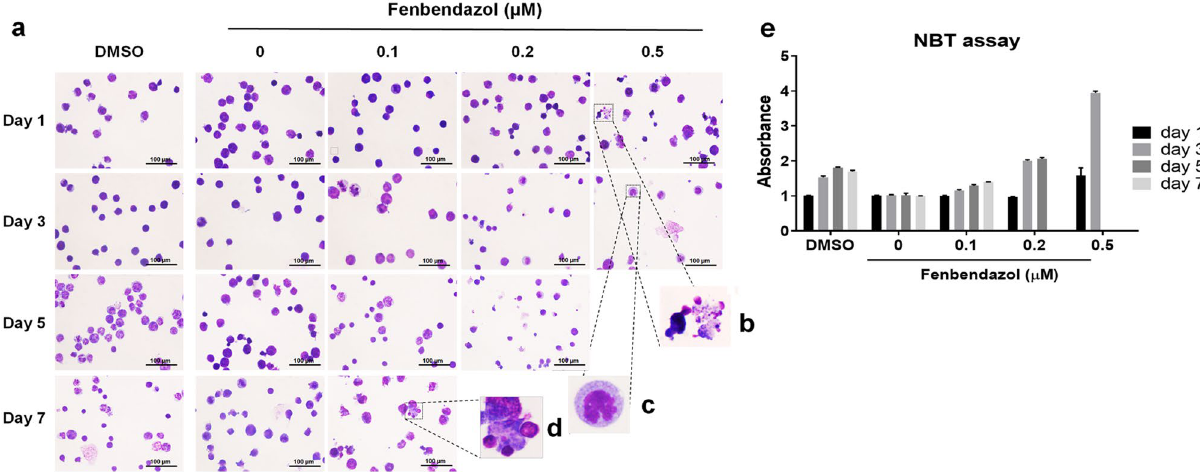
Figure 3. Fenbendazole-induced differentiation of HL60 cells to granulocytes followed by cell death: ( a ) Cell morphology at 1, 3, 5 and 7 days post treatment with 0.1 µM, 0.2 µM and 0.5 µM of fenbendazole via staining with Wright–Giemsa; ( b ) necrotic cells; ( c ) granulocytes; ( d ) apoptotic cells. ( e ) Different concentrations of fenbendazole were employed in the NBT reduction assay at different time points. The assay demonstrates that 0.5 µM of fenbendazole increased NBT reduction upon neutrophil differentiation significantly compared to positive control treatment with DMSO). Hence it can be concluded that the mode-of-action hypothesis fenbendazole inducing cell death via differentiation to granulocytes is supported by